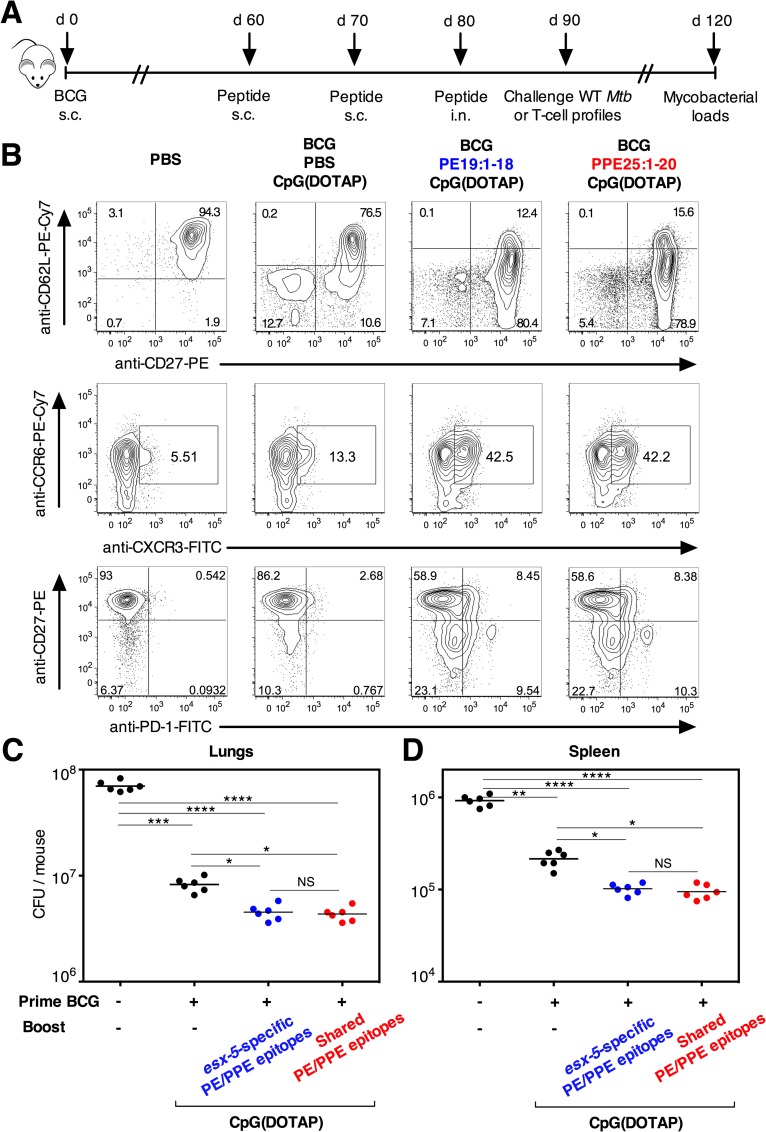
Improved protection with PE/PPE boosting in BCG-primed mice.A) BCG priming and boosting protocol with PE/PPE-derived peptides. C57BL/6 mice (n = 6 per group) were injected with PBS or immunized s.c. with BCG. Two months later, mice were vaccinated twice s.c. at 10-days interval with individual or mixtures of PE/PPE-derived peptides formulated in CpG(DOTAP), followed by an i.n. administration of the same peptides. B) Expression of T-cell activation/migration/differentiation markers by the lung CD3+ CD4+ T cells of BCG-primed, PE/PPE-boosted mice at day 90. See furthermore S8B and S8C Fig. Mice were challenged 10 days after the last immunization (day 90) with ≈ 200 CFU/mouse of Mtb H37Rv WT strain via aerosol, as determined by day 1 post challenge by CFU counting in the lungs. One month post challenge, the mycobacterial loads were determined in the lungs (C) and spleen (D) of individual mice. NS = not significant, *, **, ***, **** = statistically significant, as determined by One Way ANOVA test with Tukey’s correction for multiple comparisons, p<0.05, p<0.005, p<0.001 or p<0.0001, respectively.